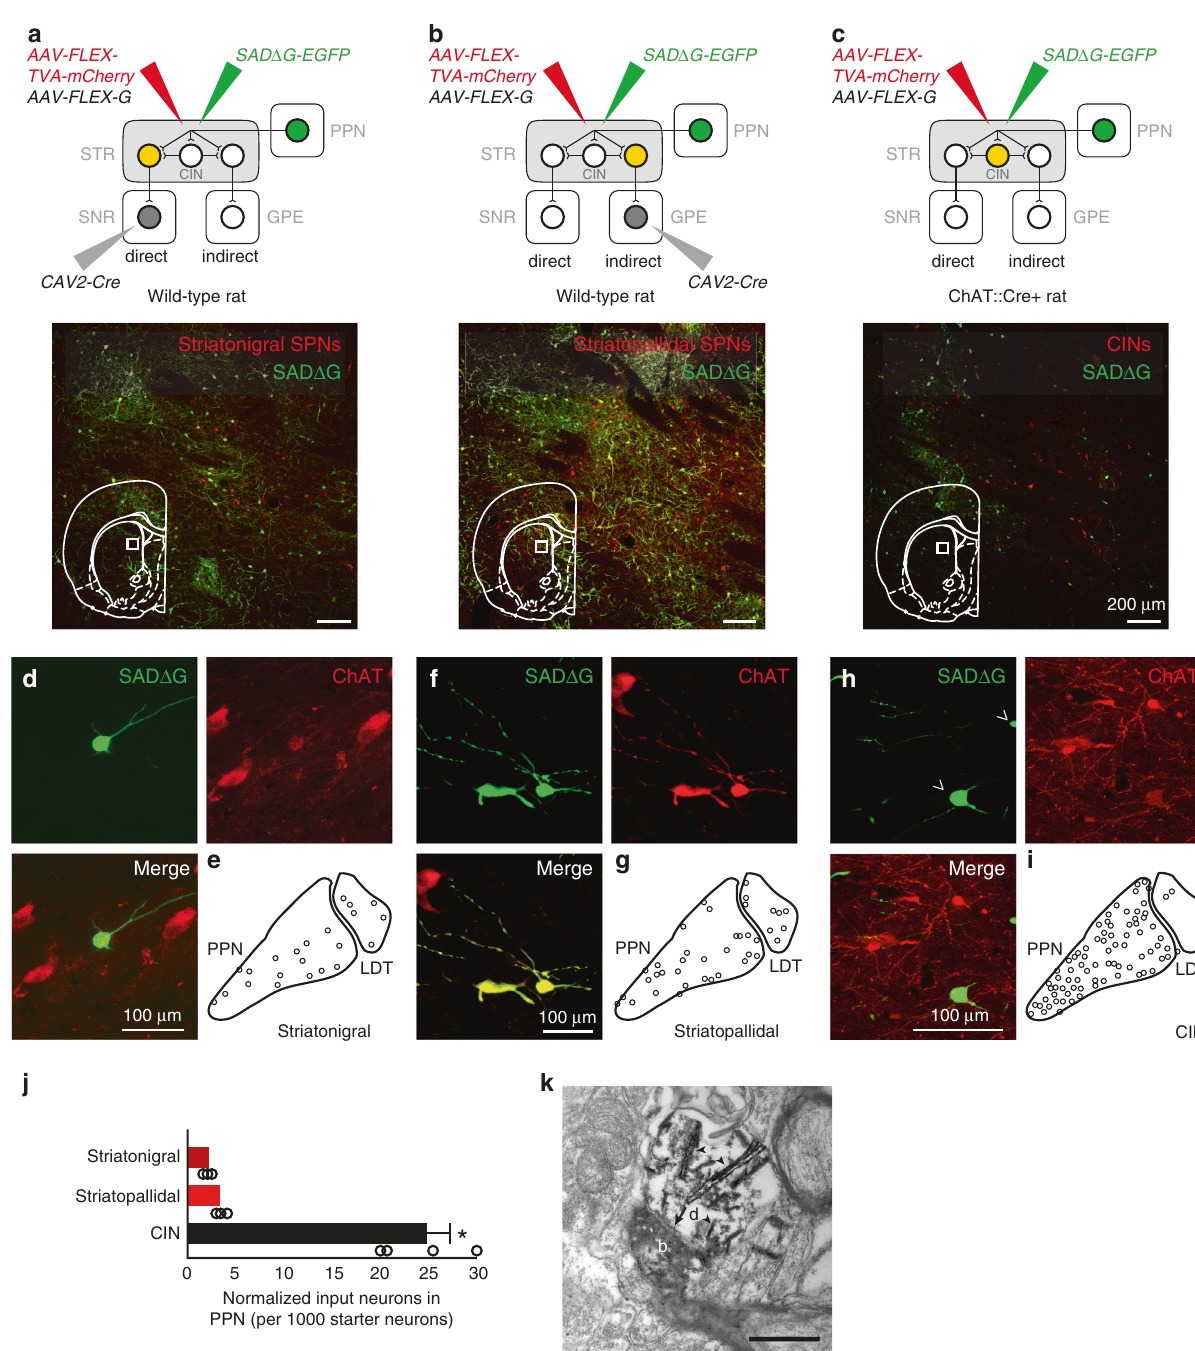
Fig. 1 Cholinergic inputs to striatal neurons. a Transsynaptic labeling of striatonigral SPNs following retrograde Cre transduction in the substantia nigra pars reticulata (SNR) and pseudorabies transduction in the striatum (STR), showing both mCherry-positive neurons (red) and YFP-positive neurons (green, input neurons), overlapping red/green signals indicated starter neurons. b Transsynaptic labeling of striatopallidal SPNs following retrograde Cre transduction in the external globus pallidus (GPE) and pseudorabies transduction in the striatum (STR). c Transsynaptic labeling of cholinergic interneurons (CINs) in the ChAT::Cre rat following pseudorabies infection in STR. d – i Cholinergic input neurons d , f , h were observed in the pedunculopontine nucleus (PPN) and the laterodorsal tegmental nucleus (LDT) ( e , g , i ; sum of three rats). j Quanti fi cation of input neurons in the PPN and LDT normalized by the number of starter neurons (each circle represents one rat, obtained from n = 3 rats in striatonigral and striatopallidal labeling, and n = 4 rats in CINs [an extra animal was added to the analysis]), suggesting that CINs are preferentially targeted by PPN neurons (Kruskal – Wallis test H (2) = 7.436, P = 0.0243, post hoc Tukey test: P = 0.958, P = 0.0001, P = 0.0001). k Electron microscope image showing an iSPNs-dSPNs iSPNs-CINs dSPNs-CINs asymmetric synapse in the striatum (black arrow) formed between a cholinergic YFP + bouton ( b ; from the PPN) and a CIN dendrite d . Arrowheads show the accumulation of TMB crystals. Scale bar: K, 500 nm. Individual data points and mean ± SEM are shown. * P < 0.05. All experiments have been replicated at least three